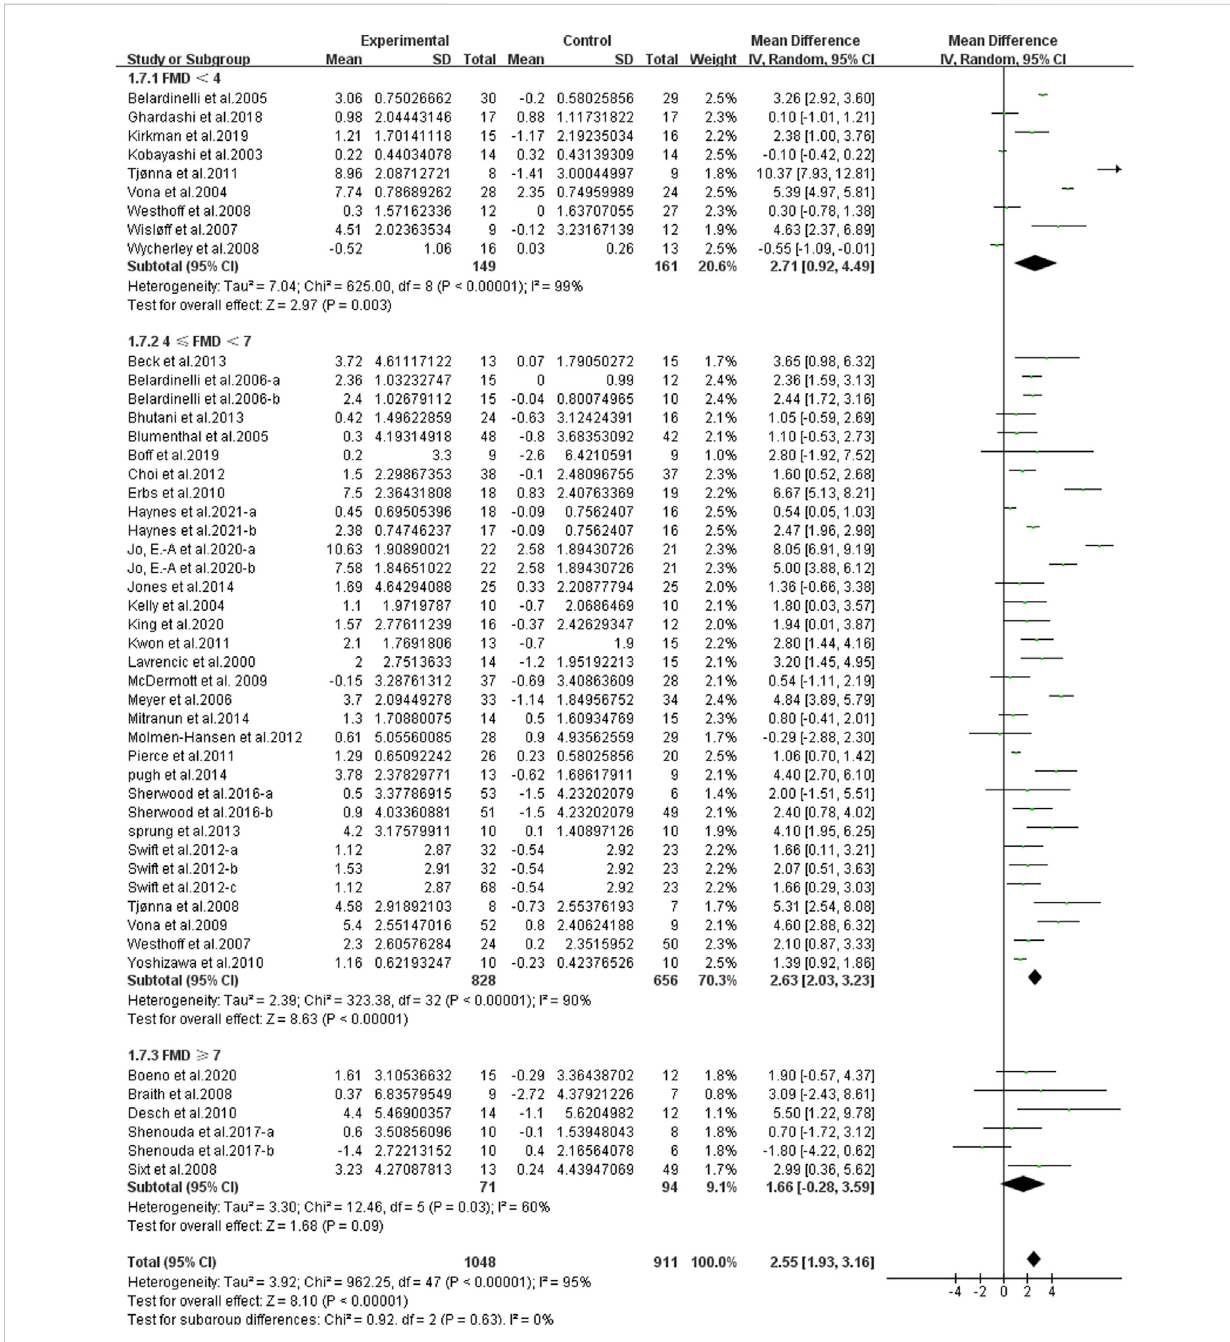
FIGURE 10 Meta-analysis results of the effect of continuous aerobic exercise on FMD in people with normal, critical, or abnormal basal FMD. The pooled estimates were obtained from random effects analysis. Diamonds indicated the size of the effect of each study summarized as WMD. The size of the shadedsquarewasproportionaltothepercentageweightofeachstudy.Horizontallinesrepresentedthe95%CIandtheverticaldashedlinerepresented the overall effect.